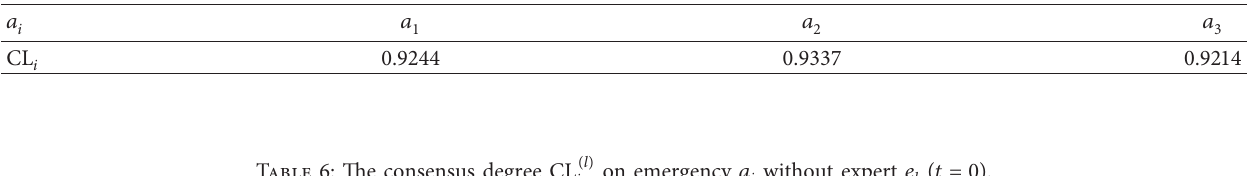
Table 5: The consensus degree CL